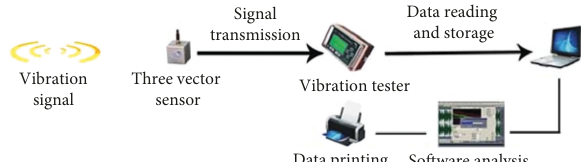
Figure 9: Working diagram of the apparatus.